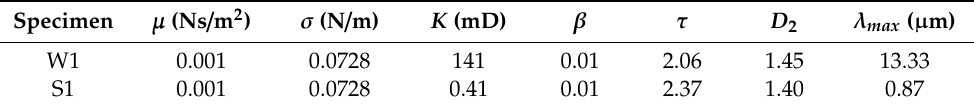
Table 6. Parameters used to predict the sorptivity of two